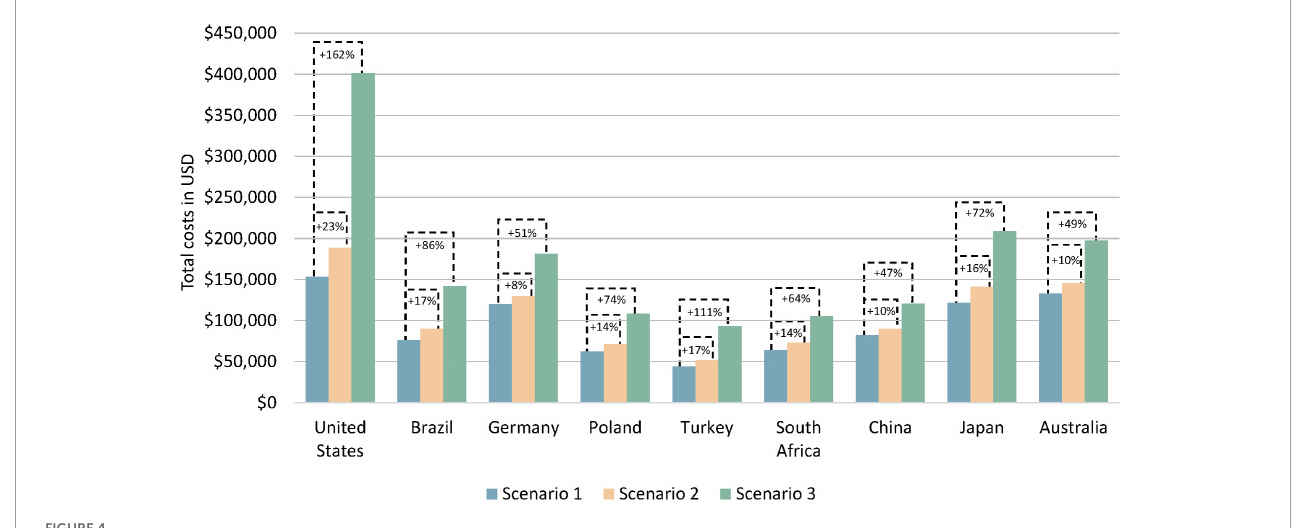
FIGURE4 Estimated total costs per patient by testing scenario over a 5-year horizon. Scenario 1 = no testing, scenario 2 = sequential testing, scenario 3 = multigene testing. Total costs are the sum of health care costs and non-health care